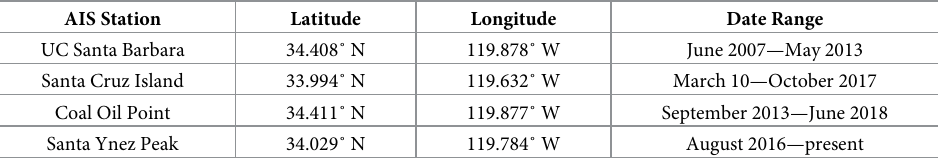
Table 1. Automated identification system data